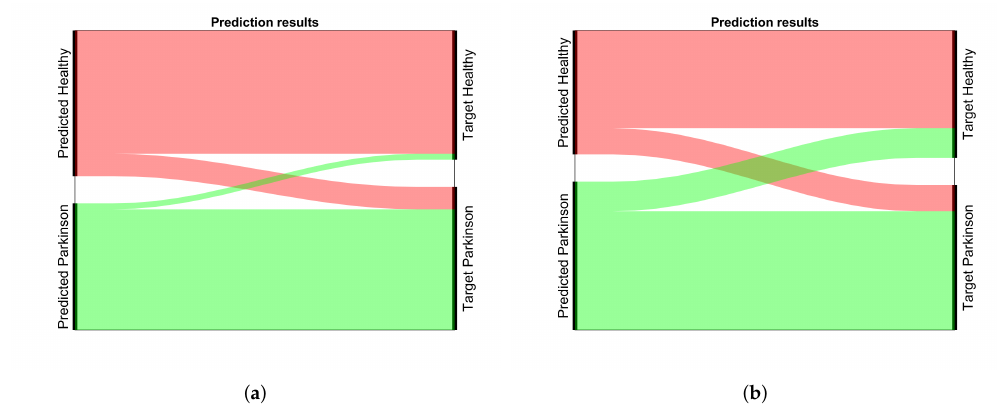
Figure 8. Alluvial plot of the classification results: ( a ) ItalianPVS dataset, and ( b ) Lithuanian voice